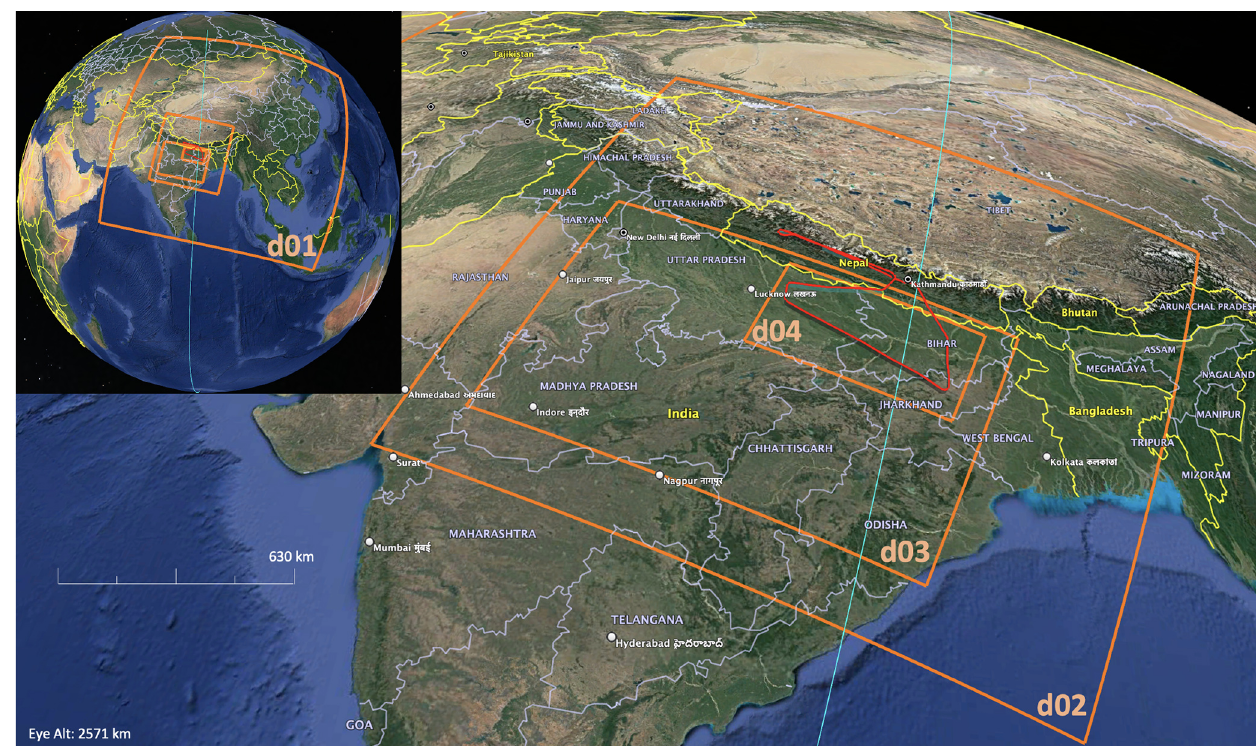
Figure 3. The four WRF nested domains (orange), the Flight 8 trajectory (red), and the closest CALIPSO passage (cyan). The map was made using © Google Earth